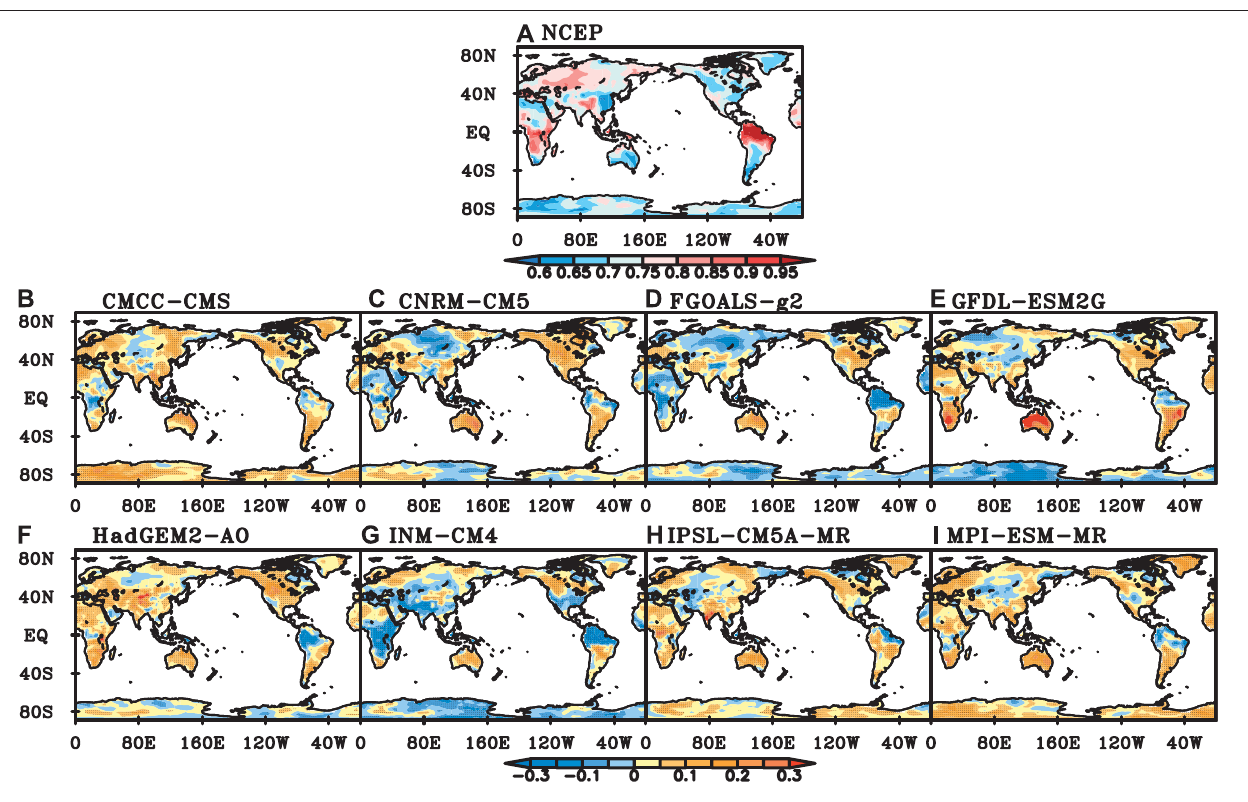
FIGURE 7 | ScalingexponentsofNCEPSAT (A) anddifferencebetweenNCEPand thoseofSATsimulated by (B) CMCC-CMS, (C) CNRM-CM5, (D) FGOALS-g2, (E) GFDL-ESM2G, (F) HadGEM-AO, (G) INM-CM4, (H) IPSL-CM5A-MR, (I) MPI-ESM-MRinspring.(Blackdotrepresentsthedifferenceissigni fi cantatasigni fi cancelevelof0.05).